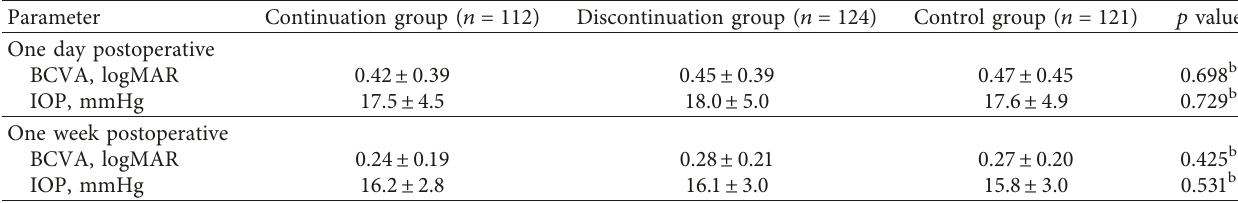
Table 3: Postoperative BCVA and IOP by group.